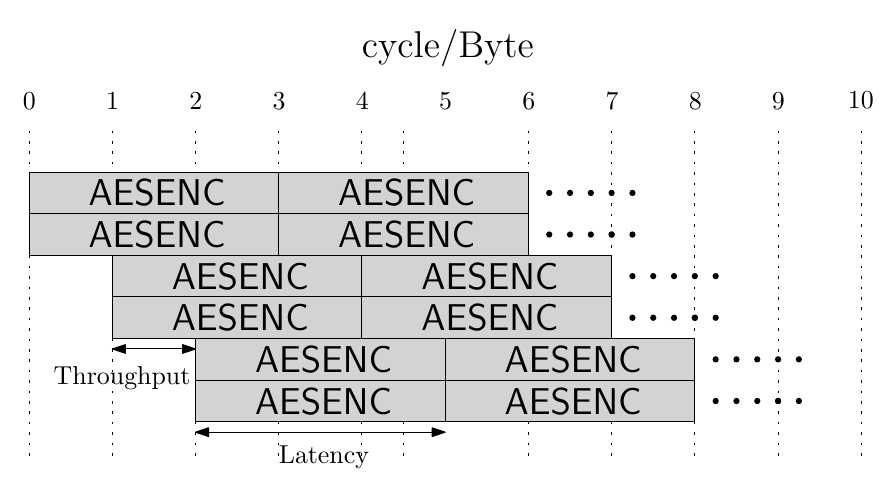
Figure 3: The process of aesenc for Intel Ice-lake.